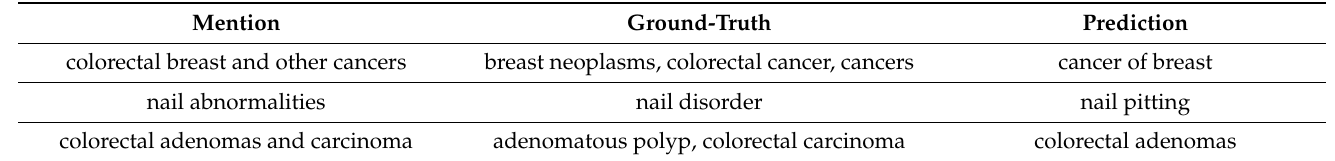
Table 9. Sample of error